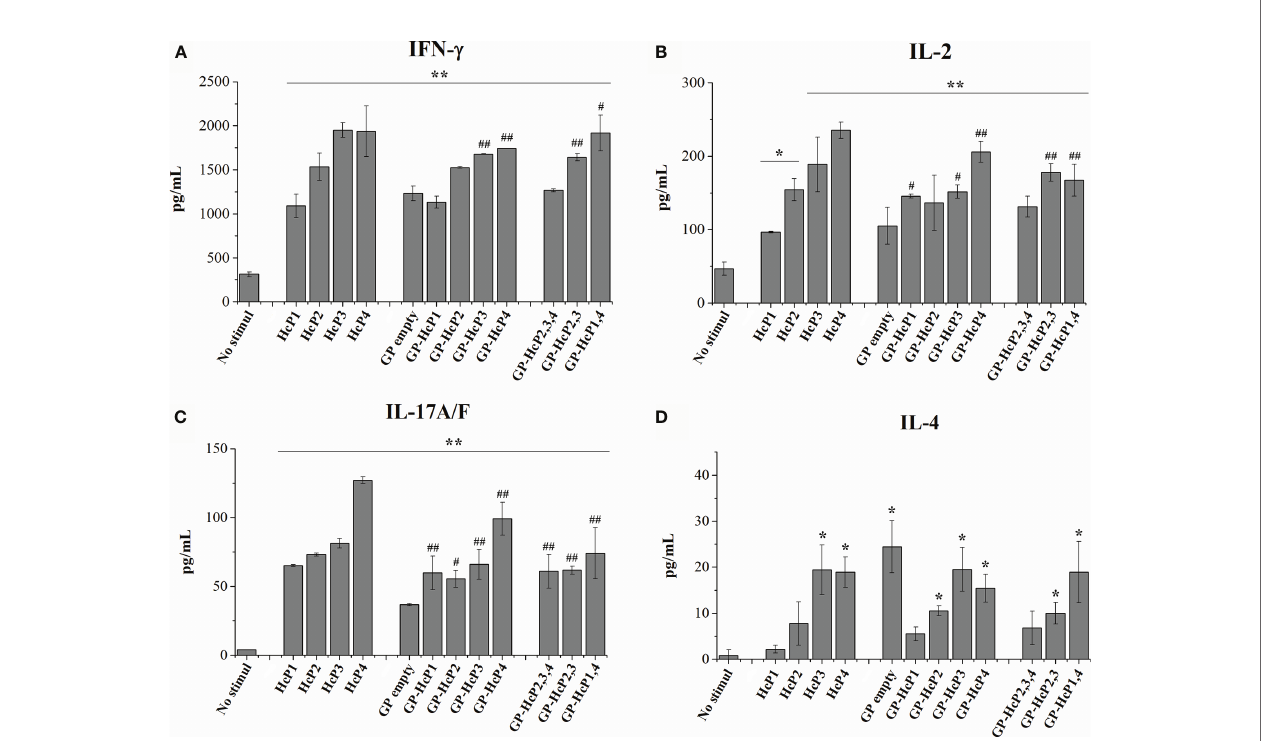
FIGURE 8 | Cytokines levels of (A) IFN- g , (B) IL-2, (C) IL-17 and (D) IL-4 after 72 hours of lymphoproliferation. HcP 1-4 was tested to 10 µg/200µL, GP-HcP 1-4 and GP-HcP 2,3,4; 2,3 or 1,4 was tested to 5 µg/200µL. Data shown are representative of two independent experiments. Difference from positive control by the Tukey ’ s test, *p < 0.05 or **p < 0.01. Difference from GP empty by the Tukey ’ s test, # p < 0.05 or ## p <